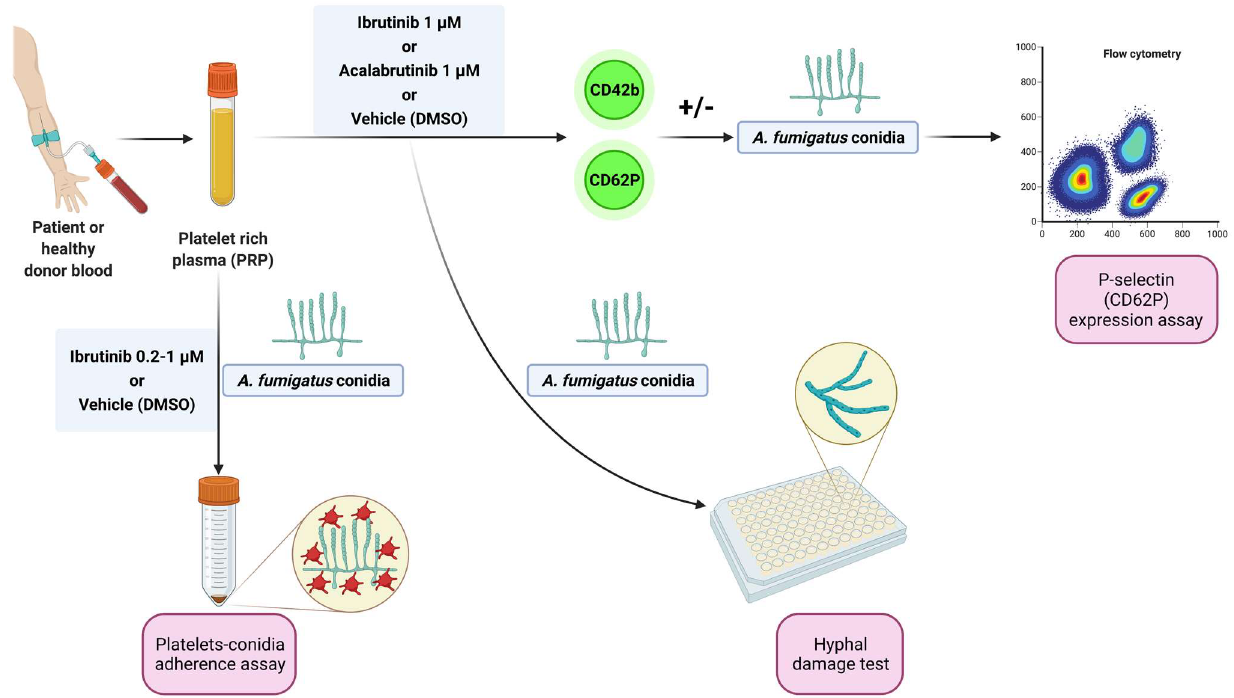
Figure 1. Experimental workflow. Platelet-rich plasma (PRP) from healthy donors and treatment- naïve CLL patients was treated with ibrutinib or acalabrutinib or vehicle (DMSO) for 60 min at 37 °C. Platelet adhesion to conidia was assessed by a spectrophotometric method. Surface expression of CD62P (P-selectin) was evaluated by flow cytometry at baseline and following stimulation by A. fumigatus conidia. Platelet-induced hyphal damage was measured by performing a colorimetric assay with XTT. Platelet-mediated antifungal activity was also evaluated in CLL patients before and after ibrutinib administration by cytofluorimetric analysis of P-selectin expression in response to A. fumigatus conidia.